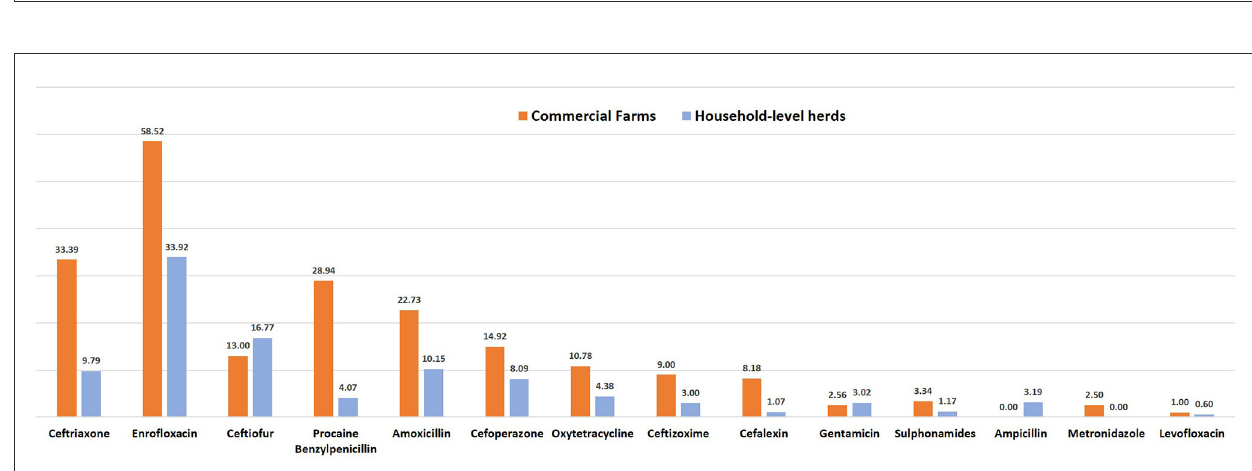
FIGURE3 Antimicrobial usage (AMU) in terms of number of animal daily dose (nADD) in household level herds and commercial farms.